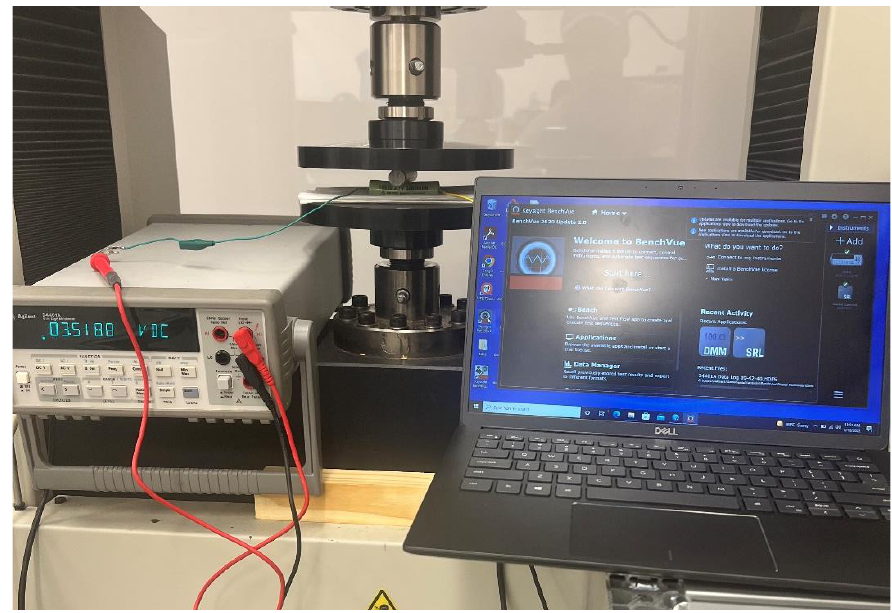
Figure 1. Experimental setup of indentation of a cylindrical LIB cell with a cylindrical indenter.